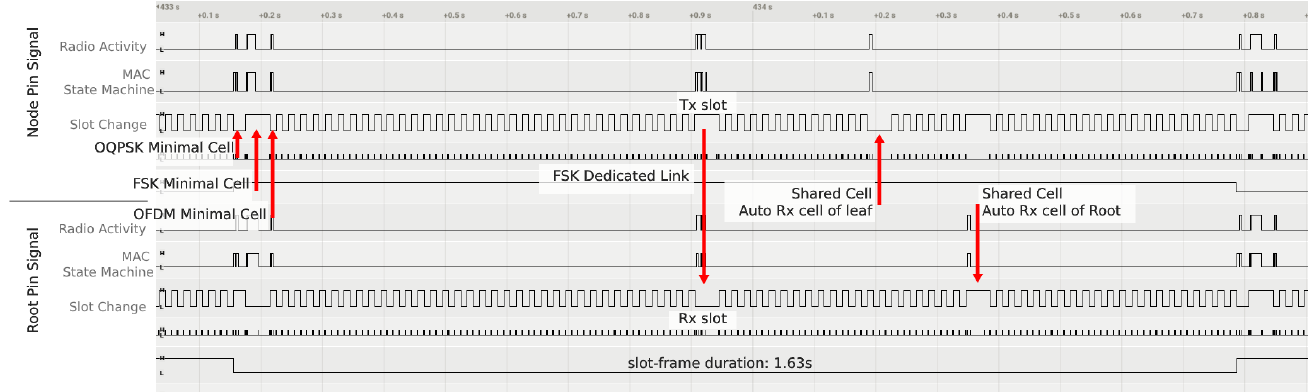
Figure 8. Logic analyzer trace showing the activity of two neighbors nodes communicating using